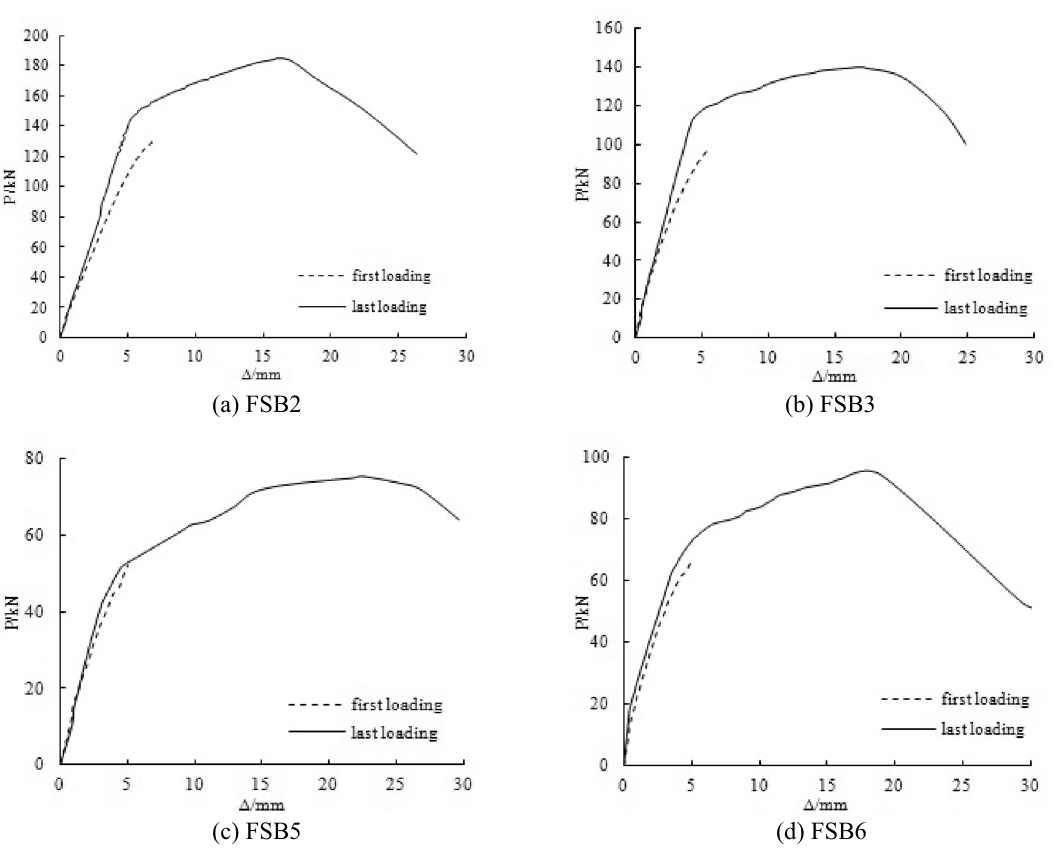
Figure 7. Load–deflection curve of strengthened steel beams under